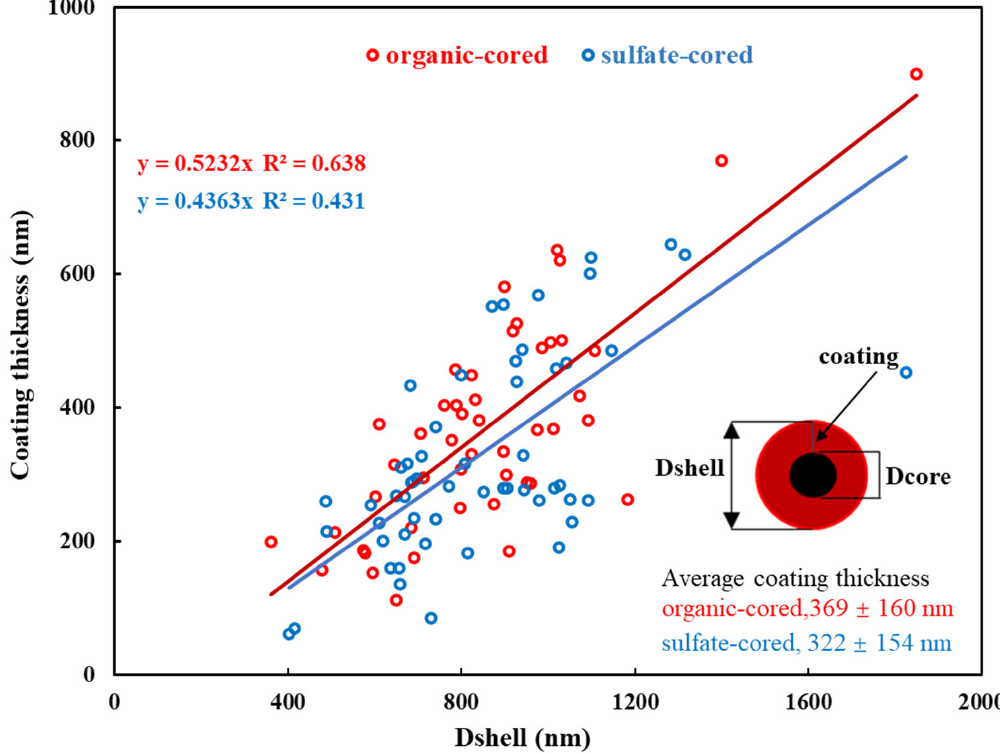
Figure 8. The correlation between the Dshell and coating thickness in the organic ‐ cored particles and sulfate ‐ cored particles in the winter haze of Xi’an during the sampling period.